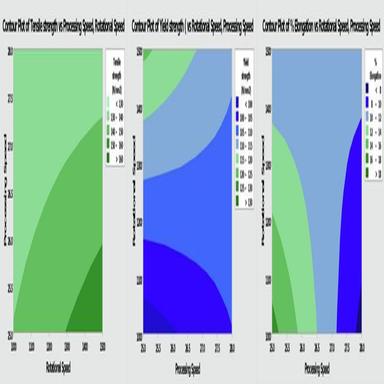
ontour Plot for (a) Tensile Strength with process parameters (b) Yield Strength with process parameters (c) % Elongation with process parameters.